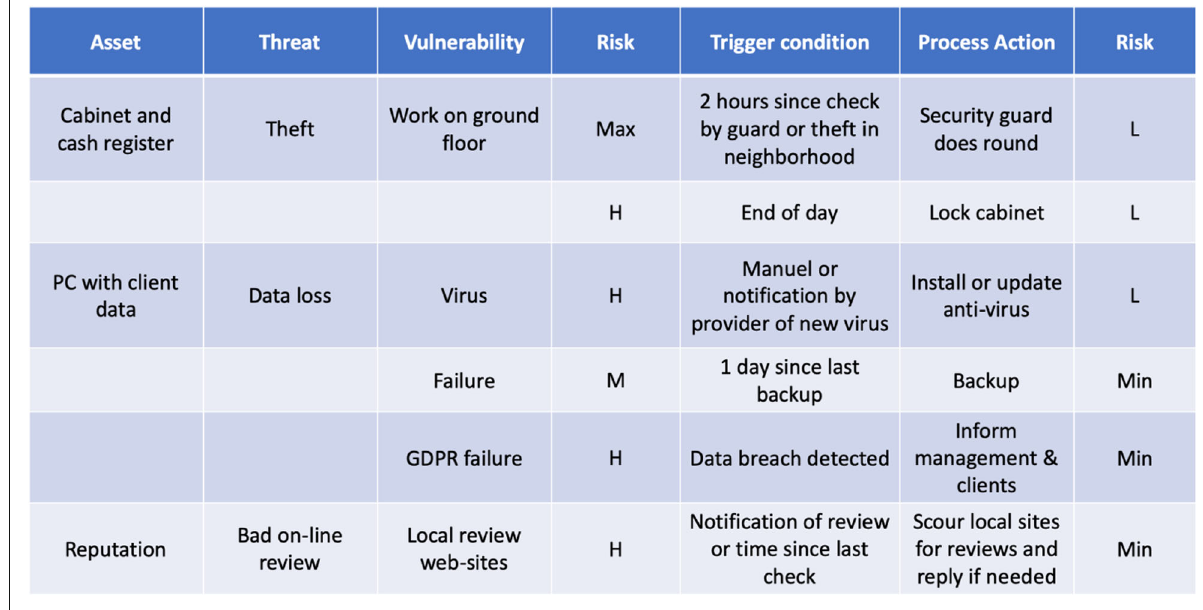
Fig. 2 Simple dashboard example